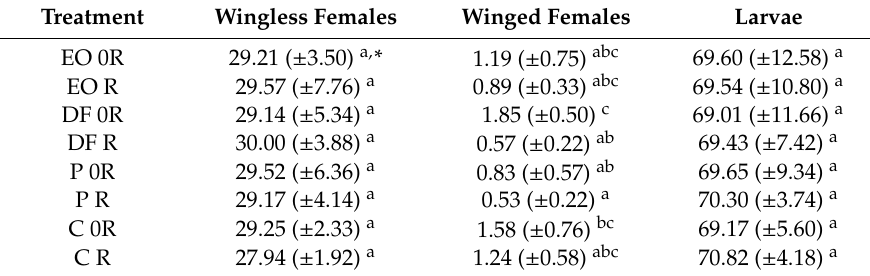
Table 1. The e ff ect of petroleum-derived substances and ZB-01 biopreparation on the proportions of particular morphotic forms of Aphis fabae Scop. (% of the total number of aphids) (average in the research season).